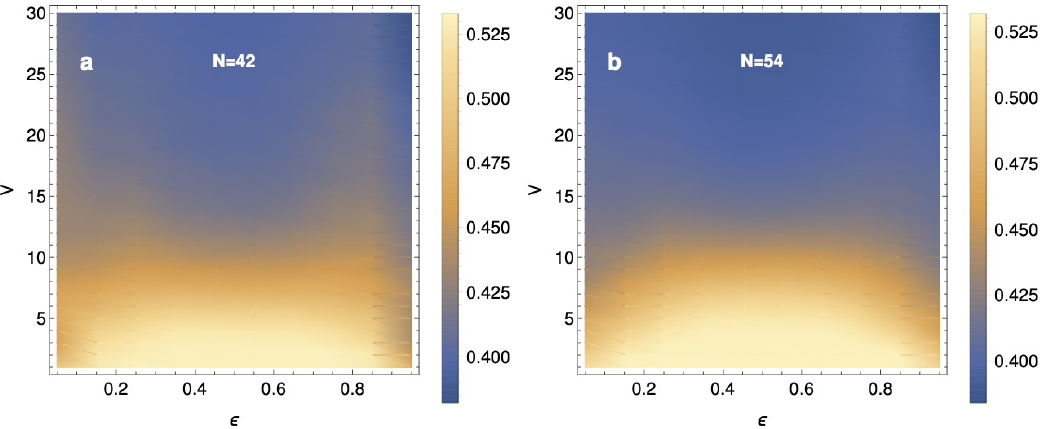
Figure 15: Color map plot of the gap ratio r as a function of the disorder strength V and the rescaled energy ε for the N = 42 (panel a ) and N = 54 (panel b ) cluster sizes, showing an energy-dependent mobility